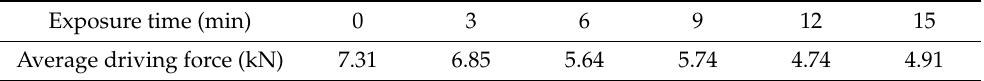
Table 3. The average driving force at different microwave exposure times.